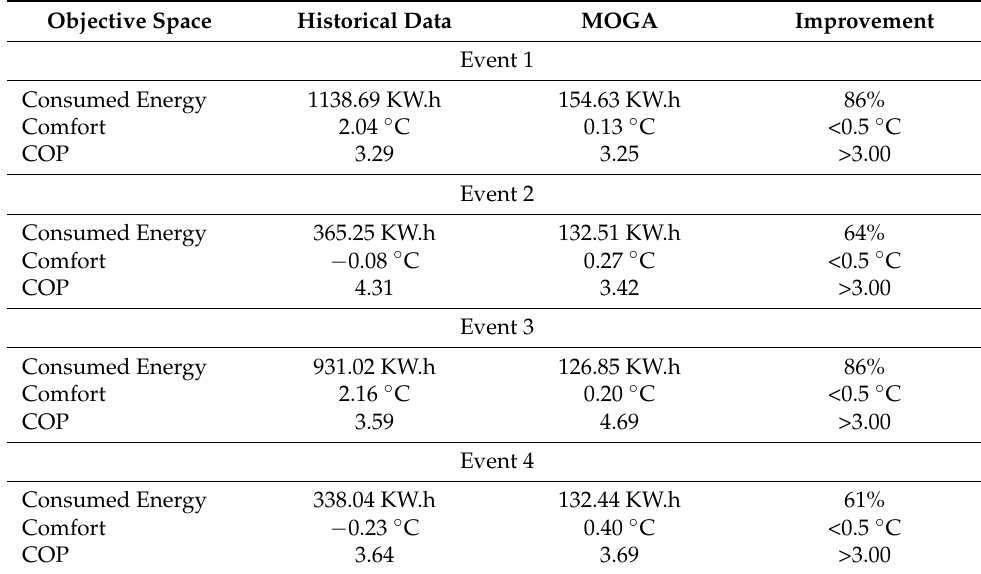
Table 6. Results obtained with MOGA optimization and comparison with real